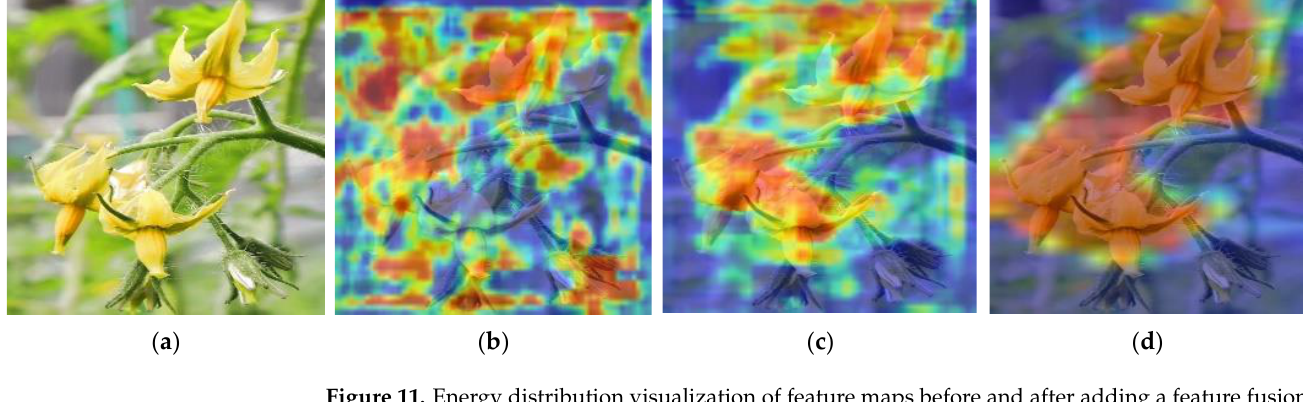
Figure 10. Recognition results of the comparison between models for different phases: ( a ) original images; ( b ) Yolov5s; ( c ) Yolov5s + fusion layer; ( d ) Yolov5s + CBAM; and ( e ) FlowerYolov5.